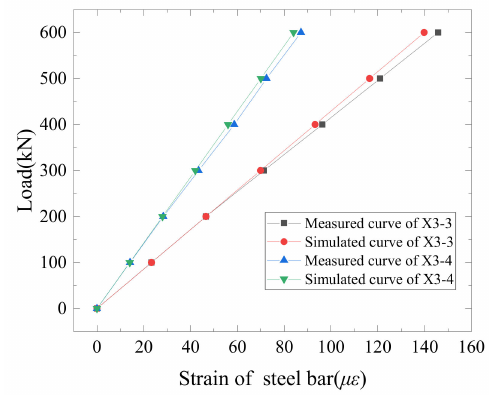
Figure 11. Comparison of finite element model and experimental